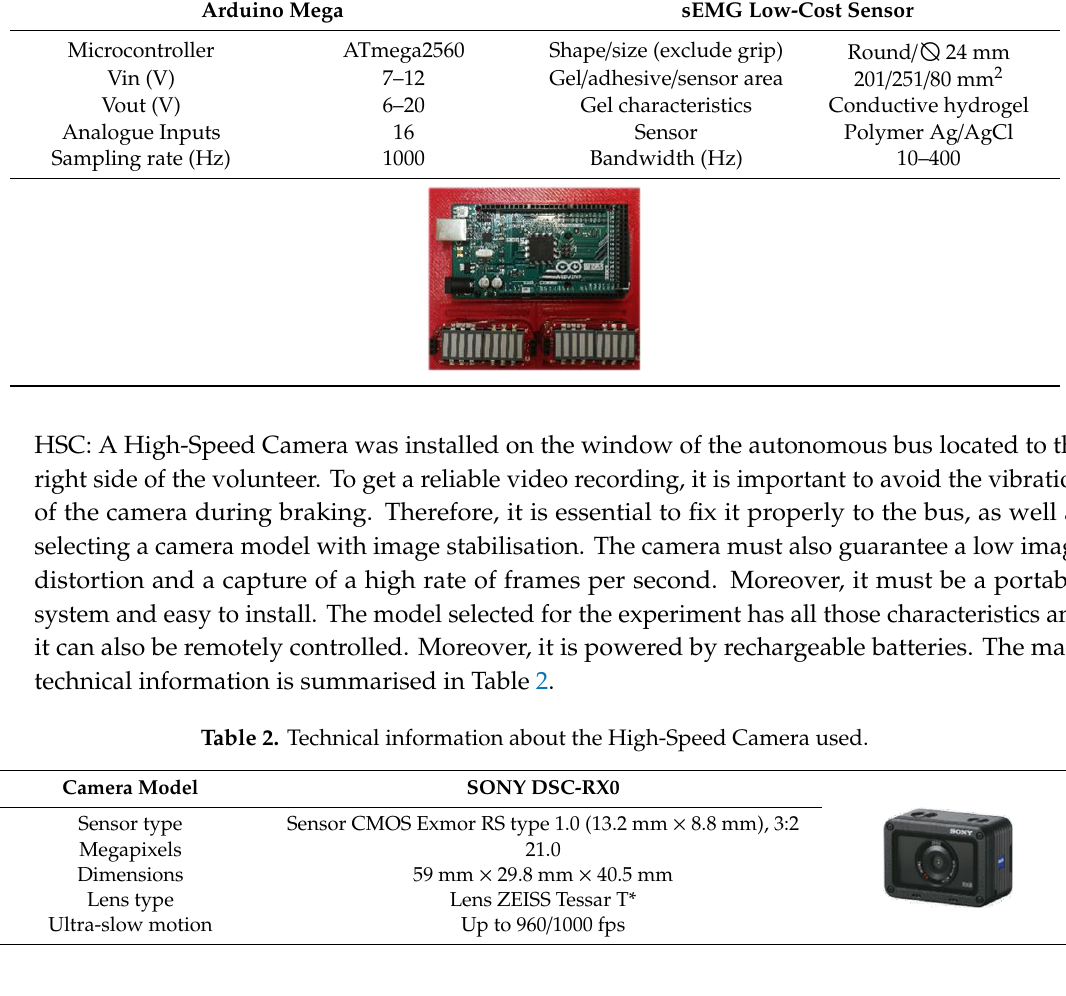
Table 3. Technical information of the accelerometer MAHA VZM